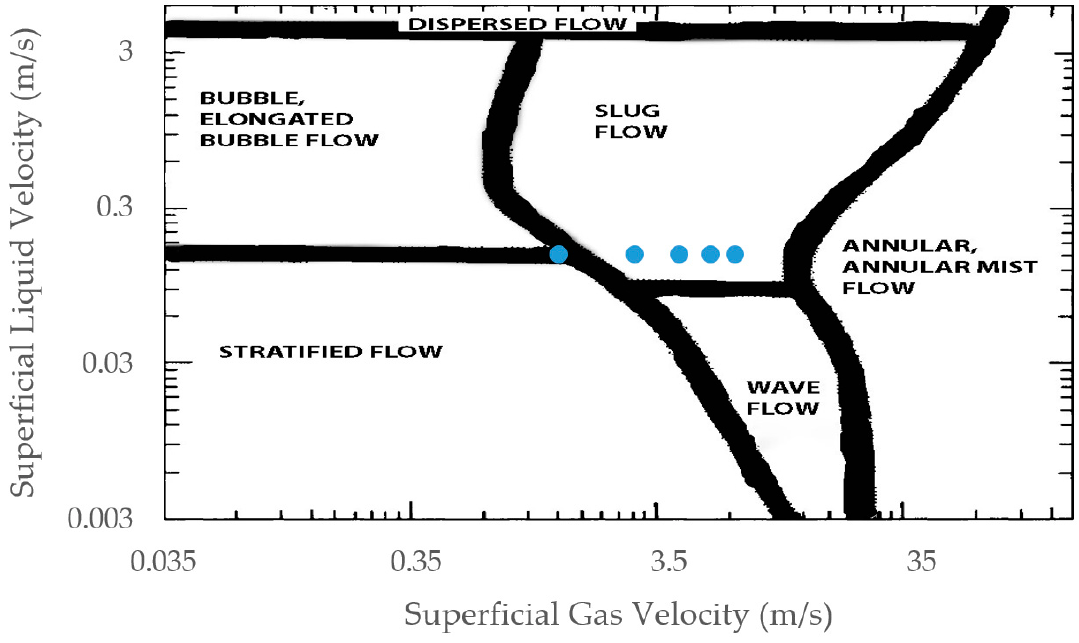
Figure 4. Flow pattern map adapted from Mandhane et al. (1974) [13].